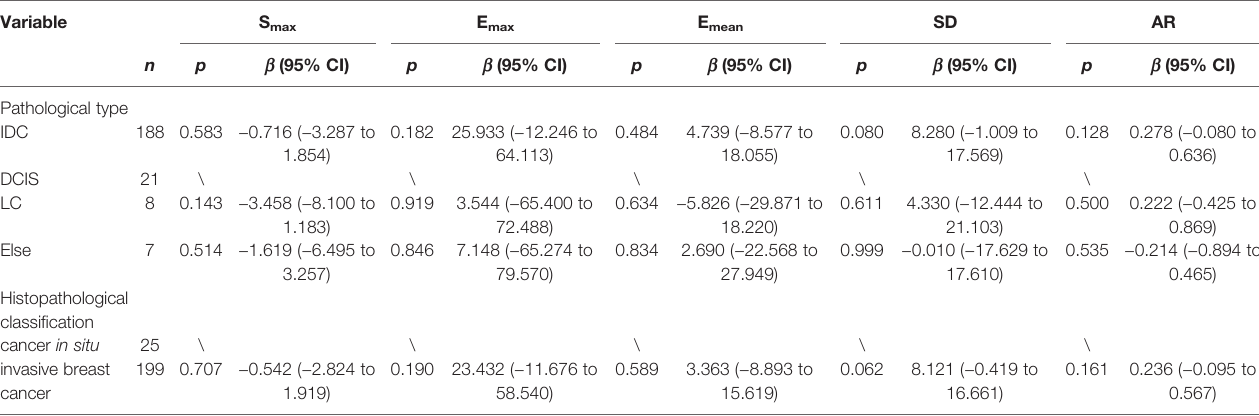
TABLE 1 | Univariate analysis of correlation of pathological type and histopathological classi fi cation with B-mode ultrasound and shear wave elastography parameters.